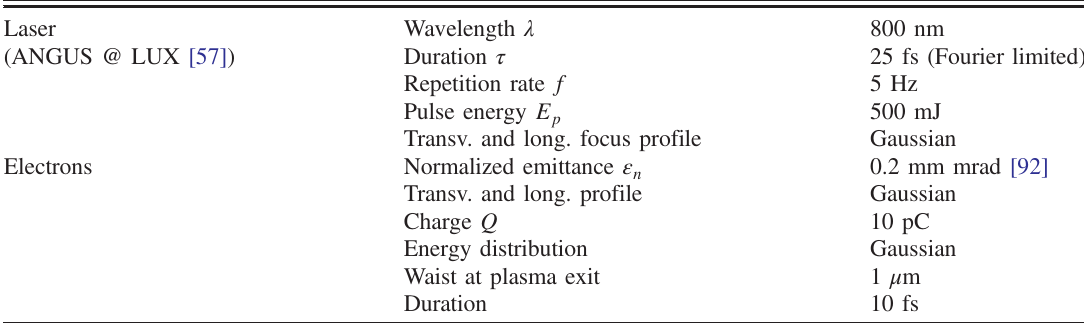
TABLE V. Initial parameters of the electron bunch and the Thomson laser. Note that except for τ these parameters are fixed for the design